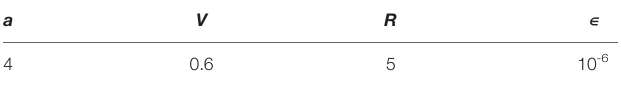
TABLE 4 | Data for the numerical tests: binary division